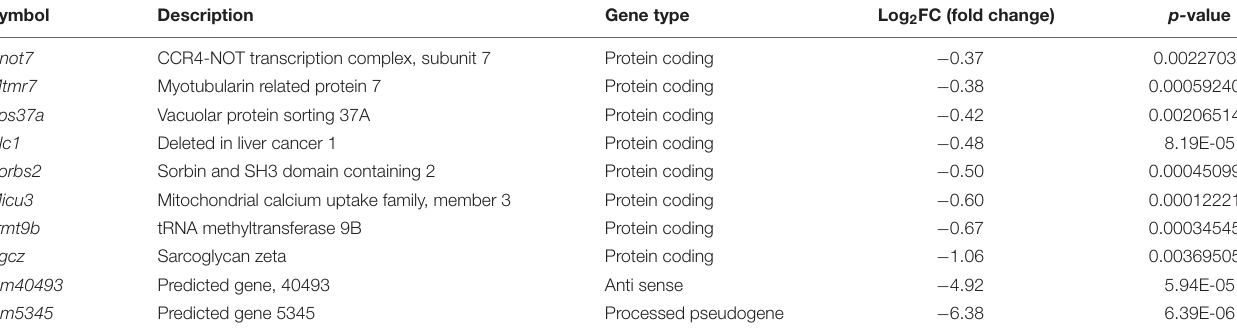
TABLE 5 | Differential gene expression between C3H and B6 determined by RNA sequencing analysis. Symbol